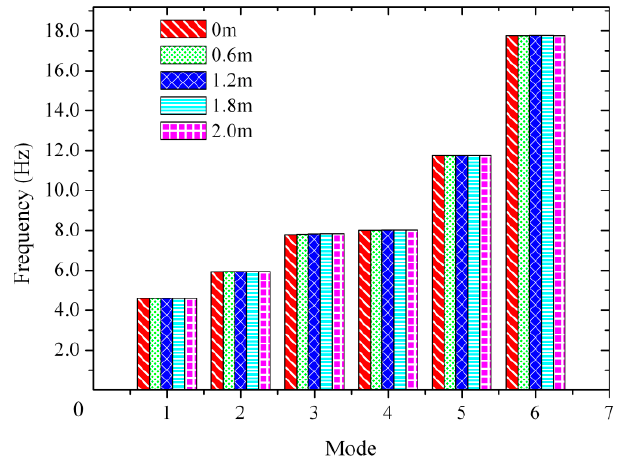
Figure 8. The first six modal frequencies with different crotch diaphragm stiffness.